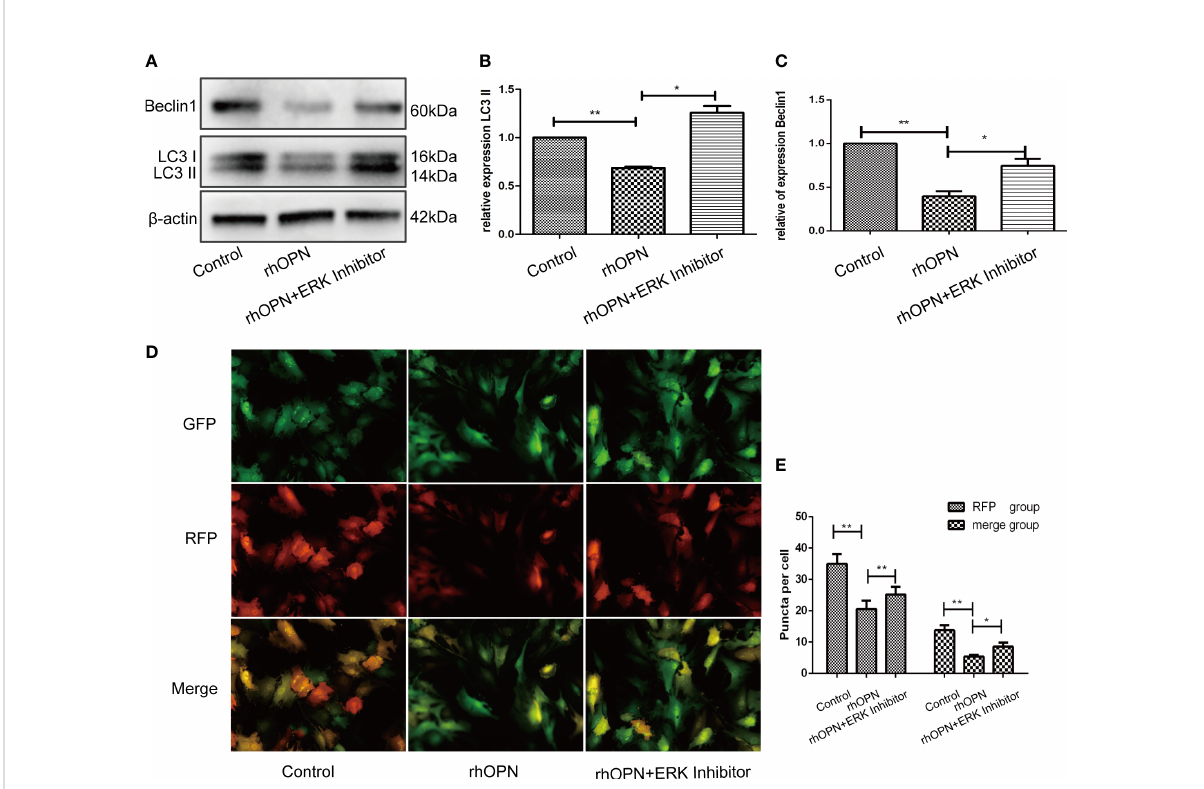
FIGURE 5 (A) Expression of beclin1 and LC3 among the control group, rhOPN group and ERK Inhibitor+ rhOPN group (n = 3); *indicates a signi fi cant difference in comparisons between the two groups ( P < 0.05); (B) Relative expression of LC3II among each group (n = 3); P = 0.0015 for the comparison between the control group and rhOPN group; P = 0.0104 for the comparison between the rhOPN group and rhOPN+ERK inhibitor group; *indicates P < 0.05, **indicates P < 0.01 for the comparisons between the two groups; (C) Relative expression of Beclin1 among each group (n = 3); P = 0.0091 for comparison between the control group and rhOPN group; P = 0.0229 for the comparison between the rhOPN group and rhOPN+ERK inhibitor group; *indicates P < 0.05, **indicates P < 0.01 for the comparisons between the two groups. (D) mRFP-GFP- LC3 puncta con fi rmed the inhibitory effects of rhOPN and rhOPN + ERK Inhibitor reversed the inhibition on LC3 II; (E) Difference in expression of LC3 in the RFP groups of control vs rhOPN and rhOPN vs rhOPN + ERK Inhibitor were statistically signi fi cant ( P = 0.0043, P = 0.0048 respectively, all of them P < 0.05, *means P < 0.05, **indicates P < 0.01); the difference in expression of LC3 in the merge groups of control vs rhOPN and rhOPN vs rhOPN + ERK Inhibitor were statistically signi fi cant ( P = 0.0013 and P = 0.0406 respectively, all of them P < 0.05, *means P < 0.05, **indicates P <